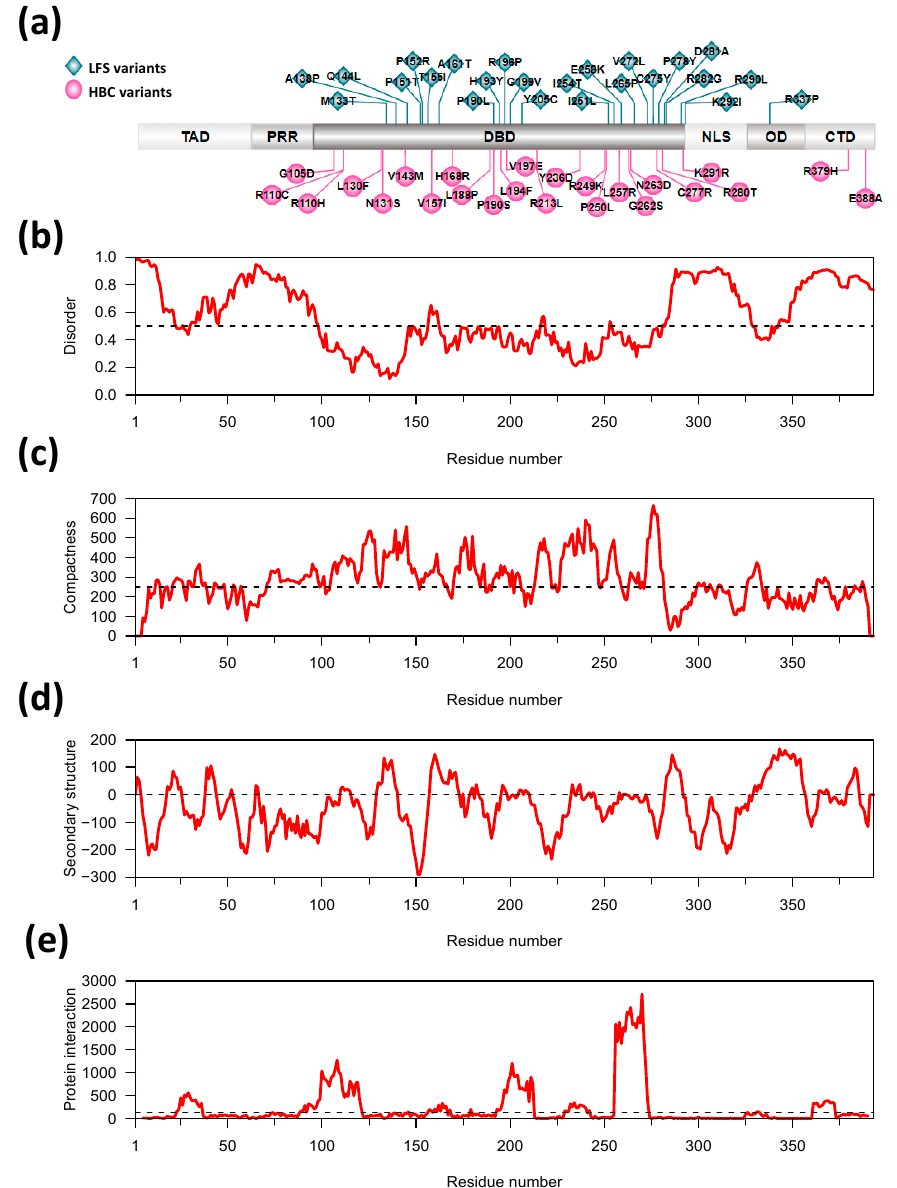
Figure 1. Location of TP53 missense variants in the TP53 protein sequence and in relation to its predicted disorder. ( a ). Schematic illustration of the TP53 amino acid sequence and protein domains with the location of the 24 LFS variants shown above (cyan green-blue rhombus) and the 24 HBC-variants indicated below (magenta purple-red circles) [39]. The TP53 domains are illustrated for the transactivation domain (TAD), the proline-rich region (PRR), the DNA binding domain (DBD), the nuclear localization signal (NLS), the oligomerization domain (OD) and the C-terminal regulatory domain (CTD). ( b ) Predicted disorder profile of wild type TP53. The IUPred2A predictor was used with the “long” argument. Scores > 0.5 (above dotted line) indicate disordered regions. The approximate location of the DBD and OD are shown (grey shading). ( c ) Predicted compactness of wild type TP53. The dotted line at a value of 250 ( y -axis) emphasizes the higher compactness values predicted for the DBD. The approximate location of the DBD and OD are shown (grey shading). ( d ) Predicted secondary structure of wild type TP53. Values > 0 (dotted line) are predicted to be alpha-helical and values < 0 are predicted to have beta-strand conformation. The approximate location of the DBD and OD are shown (grey shading). ( e ) Predicted regions with protein interaction propensity in wild type TP53. The dotted line shows a level equivalent to 5% of the maximum value. Apparently artefactual values for the first 4 residues and last 3 residues of TP53 were omitted. The approximate location of the DBD and OD are shown (grey